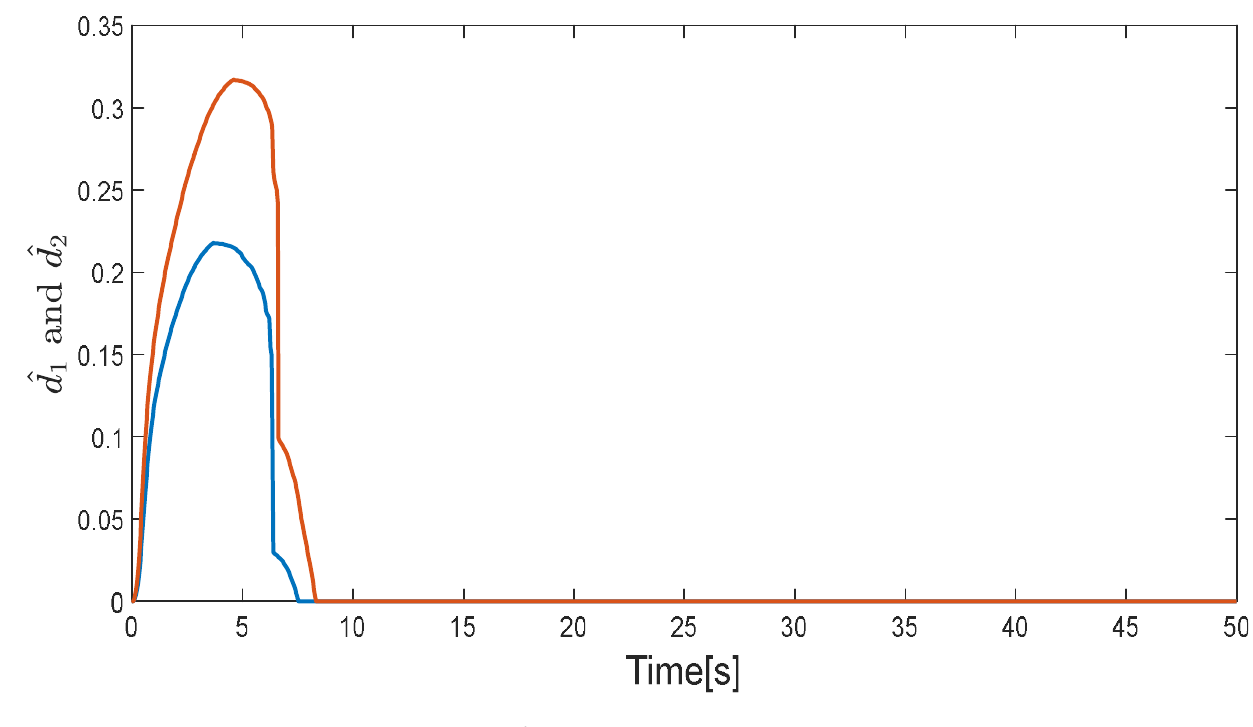
Figure 17. Comparison of torque to [43,44] in case 2: the [43] scheme (yellow solid line), the [44] scheme (red dash line), the proposed scheme (blue solid line); ( a ) Joint 1. ( b ) Joint 2.